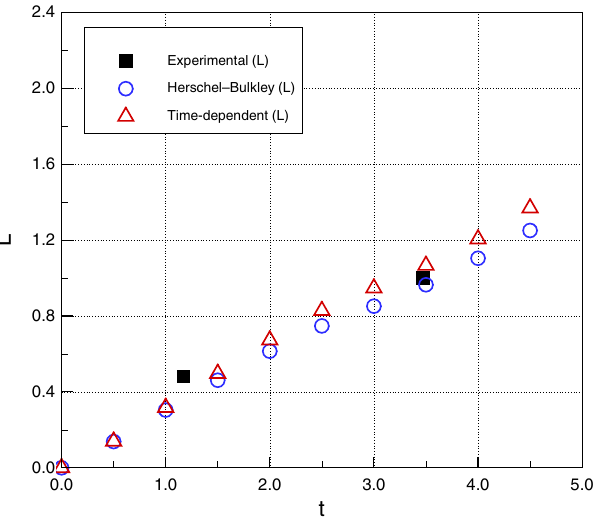
Figure 16. Subaqueous debris case 2: run-out distance ( L , m) as a function of simulation time ( t , s).